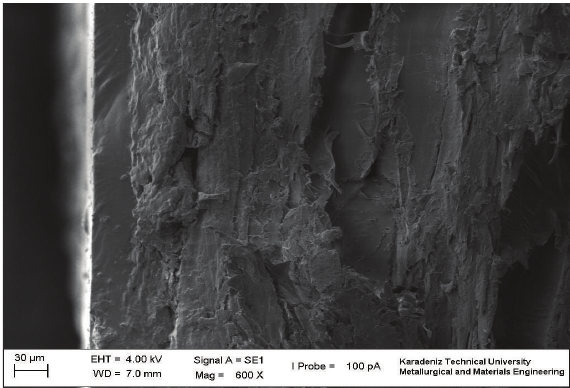
Figure 3: Cross section of heartwood beech sample.